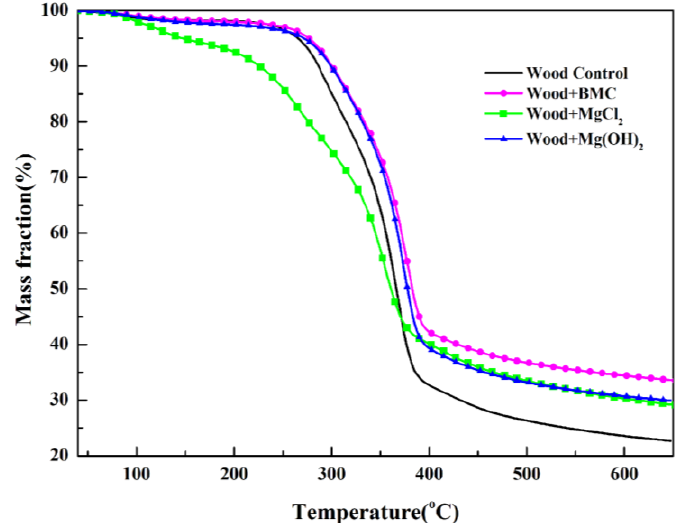
Figure 5. A comparison of TG curves of untreated and treated red gum